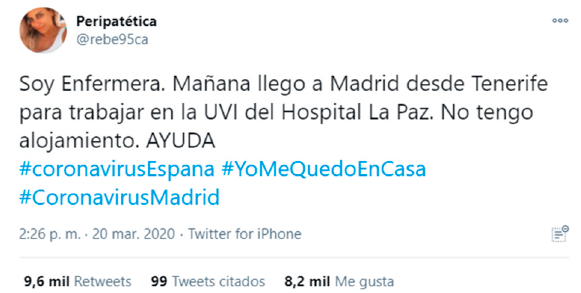
Figure 7. Example of sample content 1.